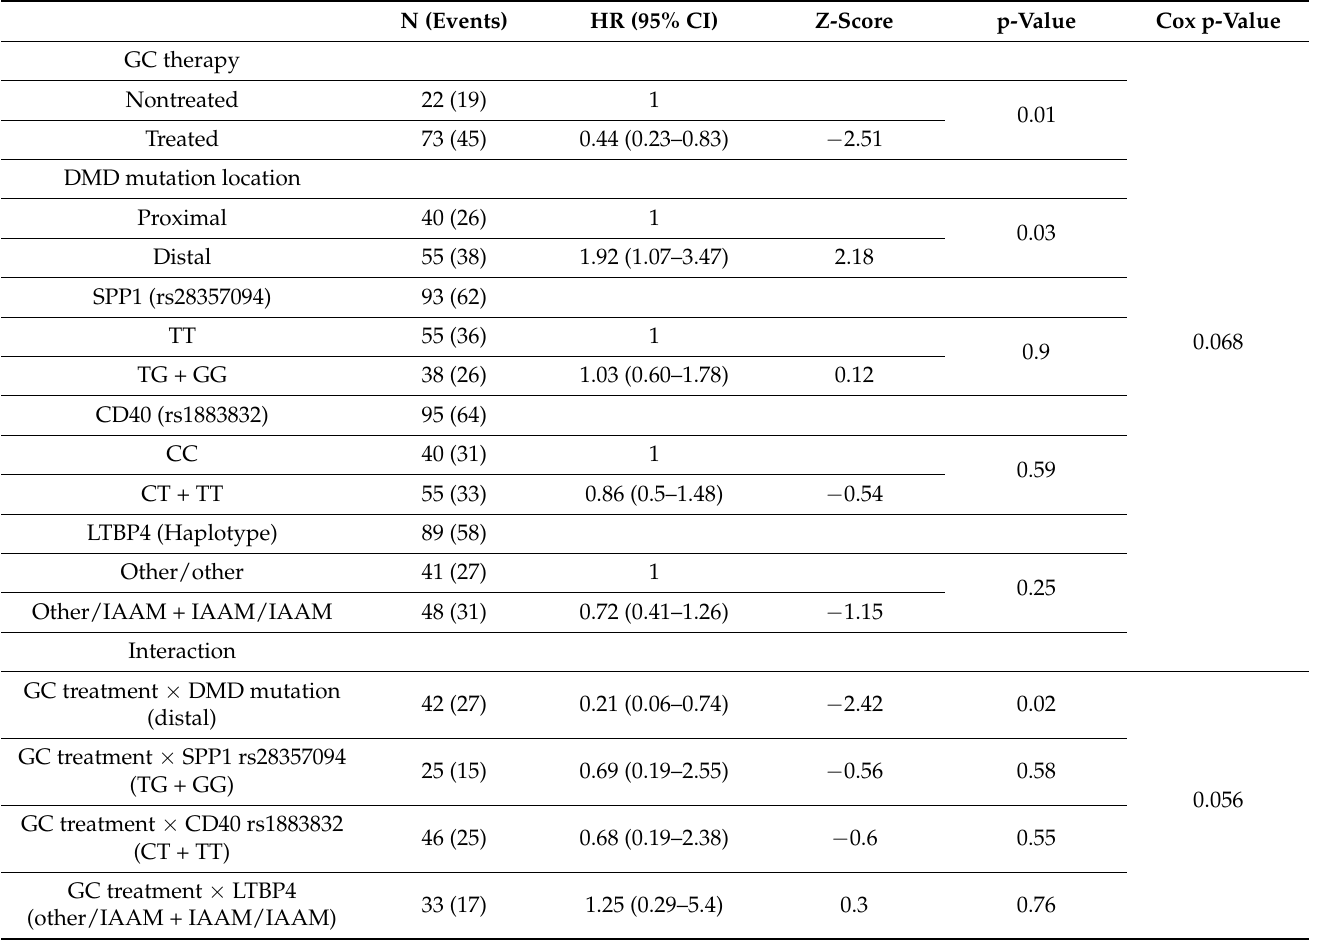
Table 2. Effect of glucocorticoid (GC) therapy, mutation location in the DMD gene, and SPP1 , CD40, and LPTB4 genes on age at loss of ambulation (LoA).